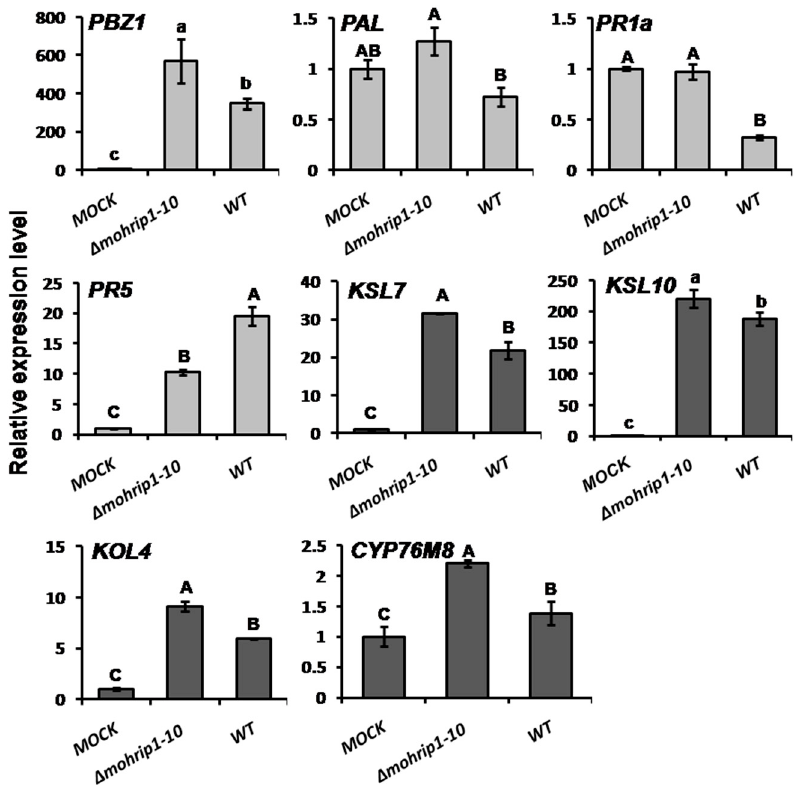
Figure 6. MoHrip1 suppresses the transcription of certain defense related genes in rice. Transcription levels of these genes were induced stronger in rice infected with Δ mohrip1-10 than WT at 3 dpi other than PR5 . The vertical axis indicates the expression levels relative to those in the water sprayed leaves (MOCK) after normalization with the rice β -Actin gene (Os11G0163100). Gray columns represent the PR or the defense pathway related genes, while brown ones represent genes taking part in the biosynthesis of phytoalexins. Three independent biological experiments were conducted, each with three replicates. Error bars represent SD. The “a”, “b”, “c” and “A”, “B”, “C” respectively represent the significance analyzed using Duncan’s multiple range test at p < 0.05 and p < 0.01. MOCK, ∆ mohrip1-10 , and WT respectively represent the rice seedlings treated with 0.2% Tween 20, mohrip1 deletion mutant and the wild type strain.